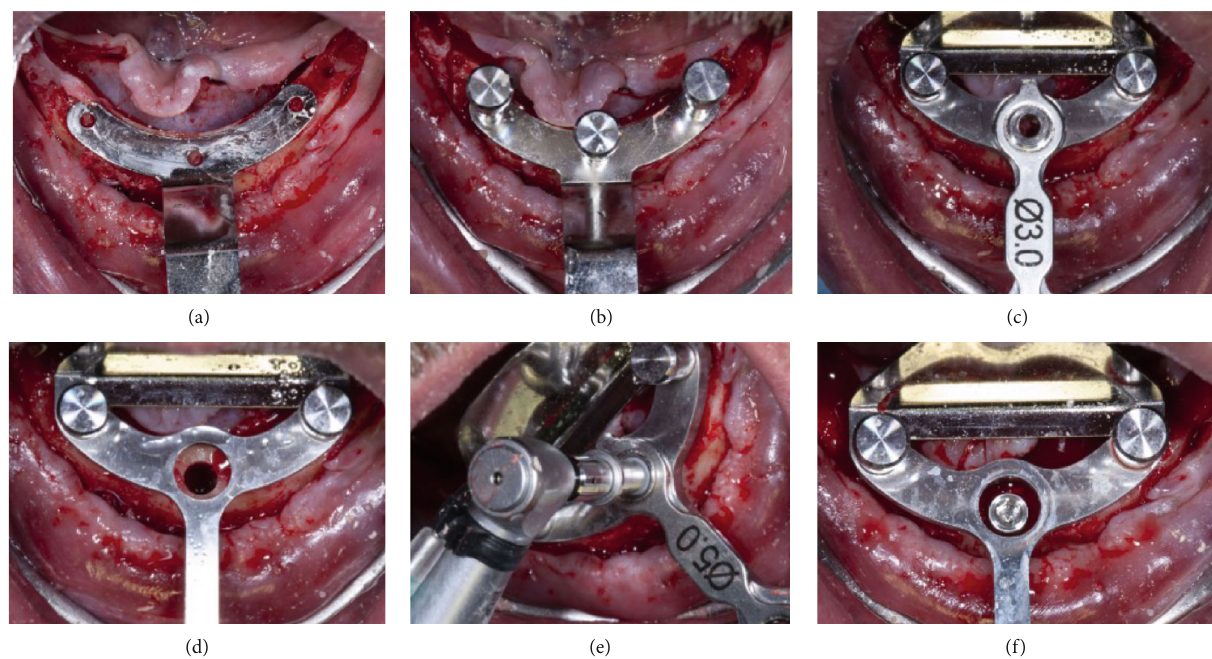
Figure 3: Intraoral view of the surgical steps (1): the fi rst surgical guide is placed (a) and fi xed (b), the central implant site is prepared thanks to metal bushings of increasing diameter (c, d), and the fi xture is inserted (e, f).